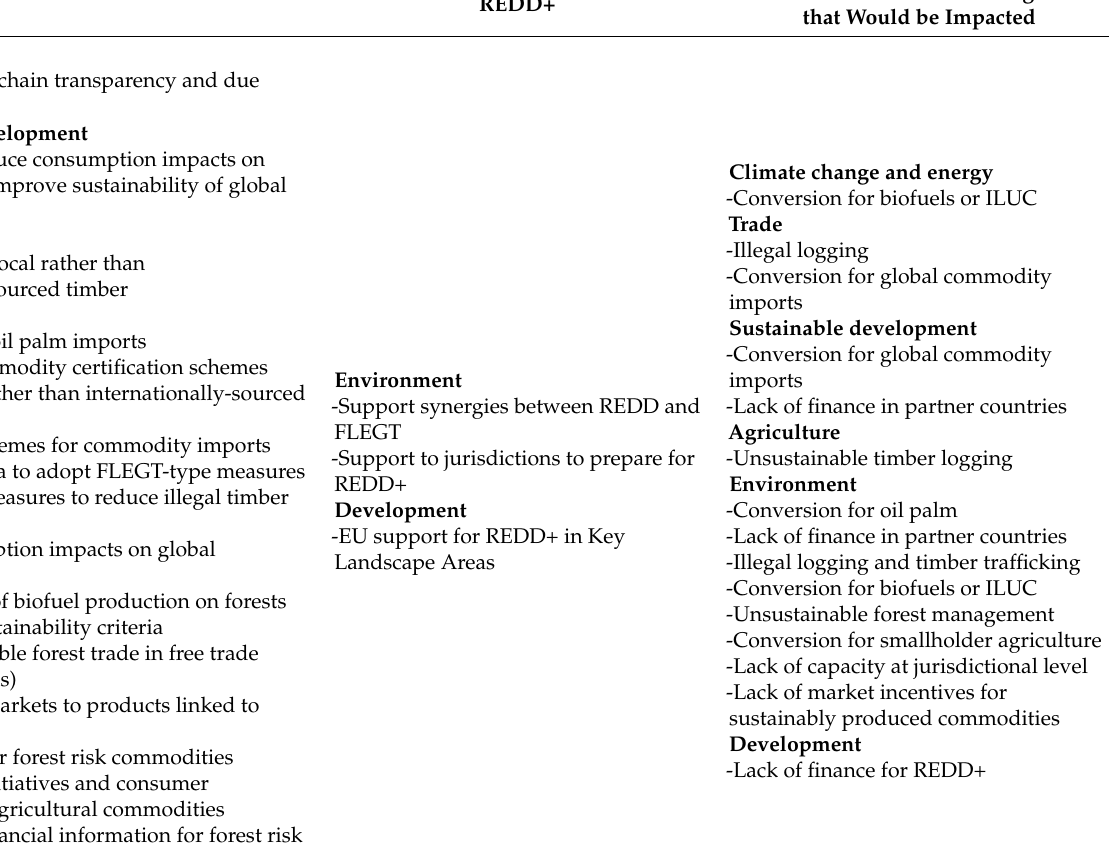
Direct and Indirect Drivers of Suggested Measures Mentioning Deforestation and Forest Degraded REDD+ that Would be